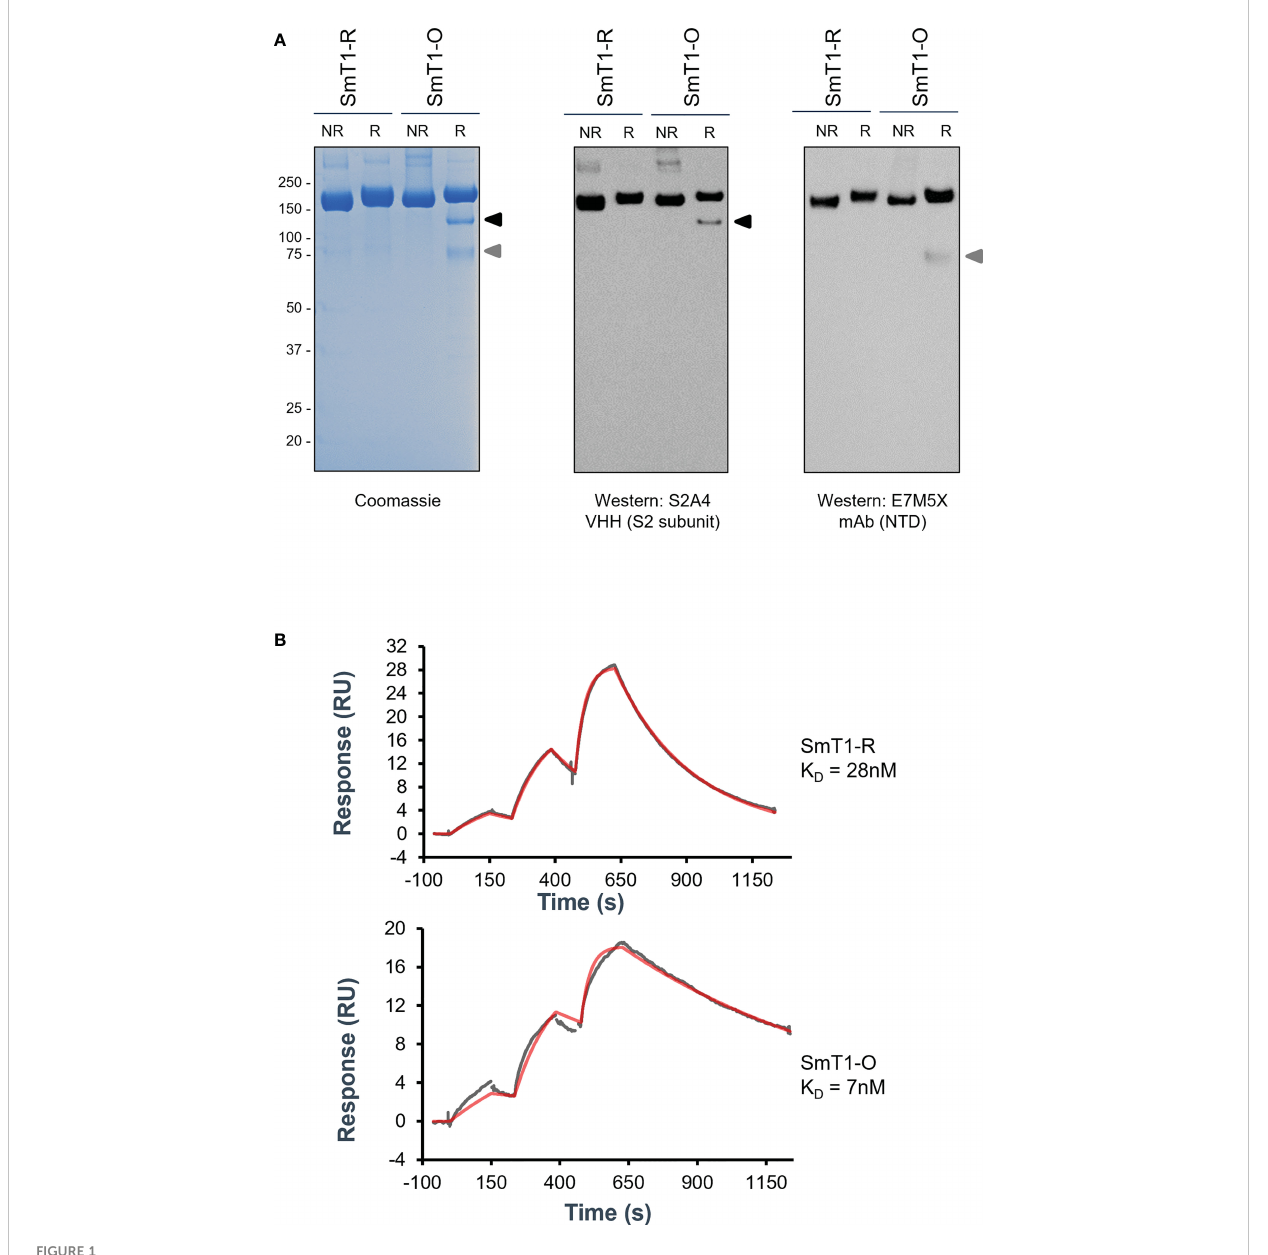
FIGURE 1 Puri fi ed SmT1-O (Omicron) spike protein exhibits non-full-length fragments by reducing SDS-PAGE and increased af fi nity for ACE2 by SPR compared to reference strain SmT1-R. SDS-PAGE of 3µg total protein analyzed via (A) Coomassie stain (Left panel) or Western blot targeting either the S2 subunit (Middle panel) or N-terminal domain (Right panel) domains. R = Reducing; NR = Non-Reducing. (B) Surface plasmon resonance binding sensorgrams showing the 1:1 binding simulated best fi t (red) and experimental data (gray) fi t for the SmT1-R (top) and SmT1-O (bottom) interaction with human